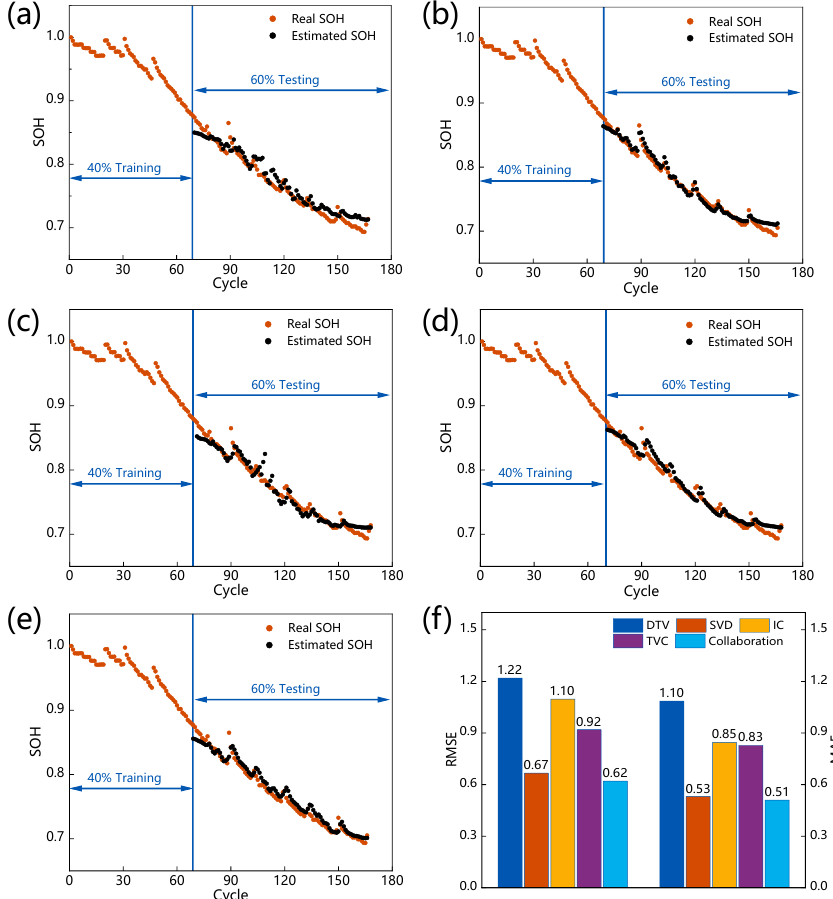
black line indicates the expected SOH. Figure 5f is a bar chart displaying the RMSE and MAE for each case.